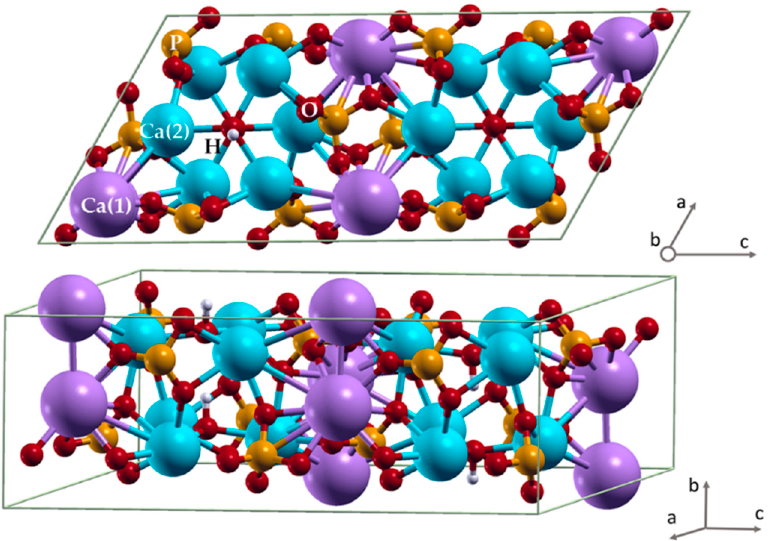
Figure 1. Hydroxyapatite unit cell. Color coding: phosphorus—orange, oxygen—red, hydrogen— light grey, Ca(1)—purple, Ca(2)—blue [11].